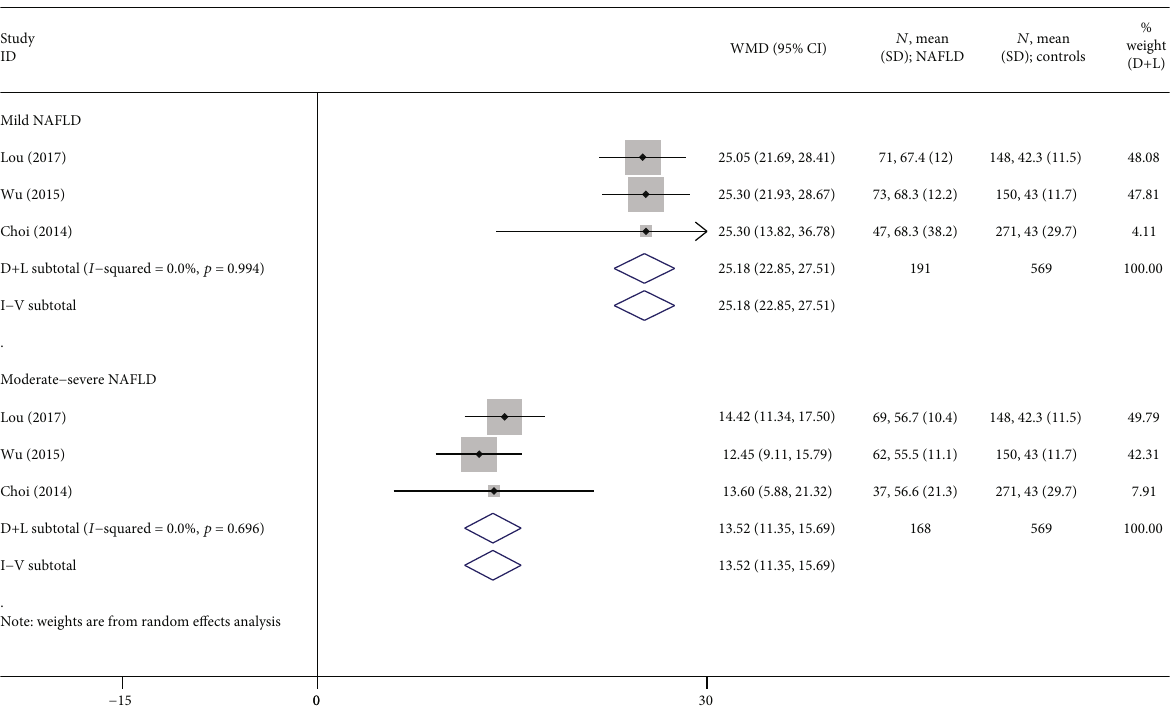
Figure 4: Forest plot analyzing the circulating irisin levels between the mild or moderate-severe NAFLD and healthy